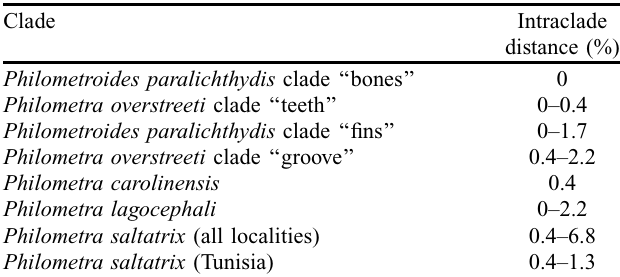
Table 2. Intra-species distances (Kimura-2 parameter) calculated from COI sequences of philometrids.